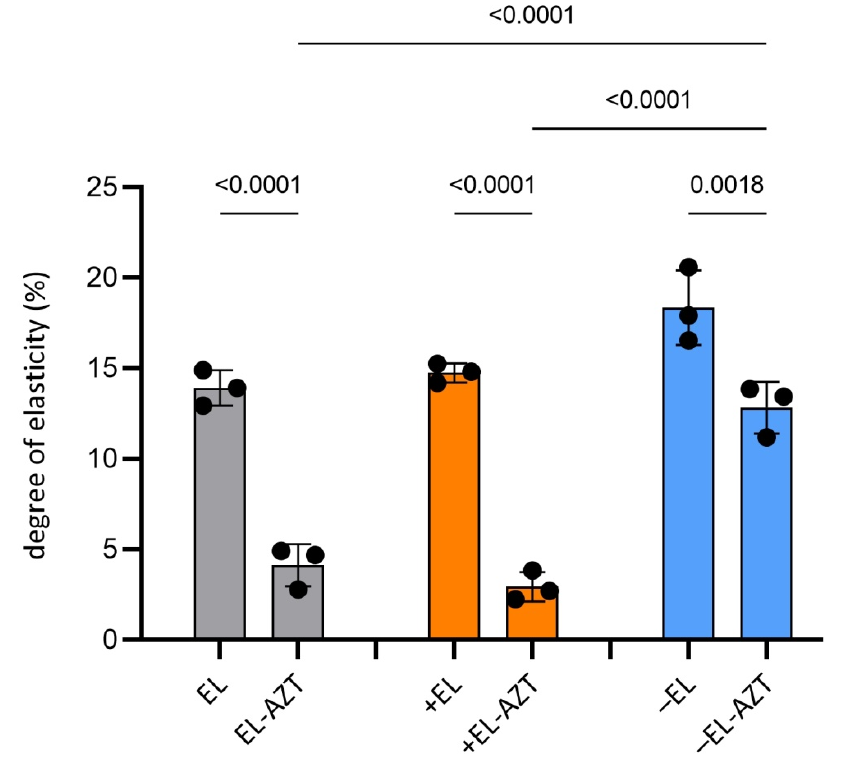
Figure 3. Degree of bilayer elasticity (E) of the different surface-charged liposomes. Data are mean ± S.D and individual values. ( n = 3). Statistically significant differences between the corresponding empty liposomes and AZT-containing liposomes and between different AZT containing liposomes are shown. Statistical analysis was performed by one-way ANOVA with post-hoc Tukey test. EL, empty neutral liposomes; +EL, empty cationic liposomes; − EL, empty anionic liposomes; EL-AZT, neutral liposomes with azithromycin; +EL-AZT, cationic liposomes with azithromycin; − EL-AZT, anionic liposomes with azithromycin.